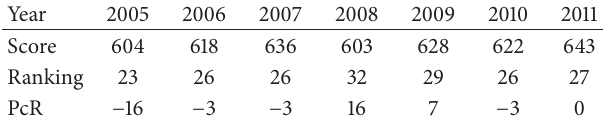
Table 1: Scores, ranking, and PcR of the instance.